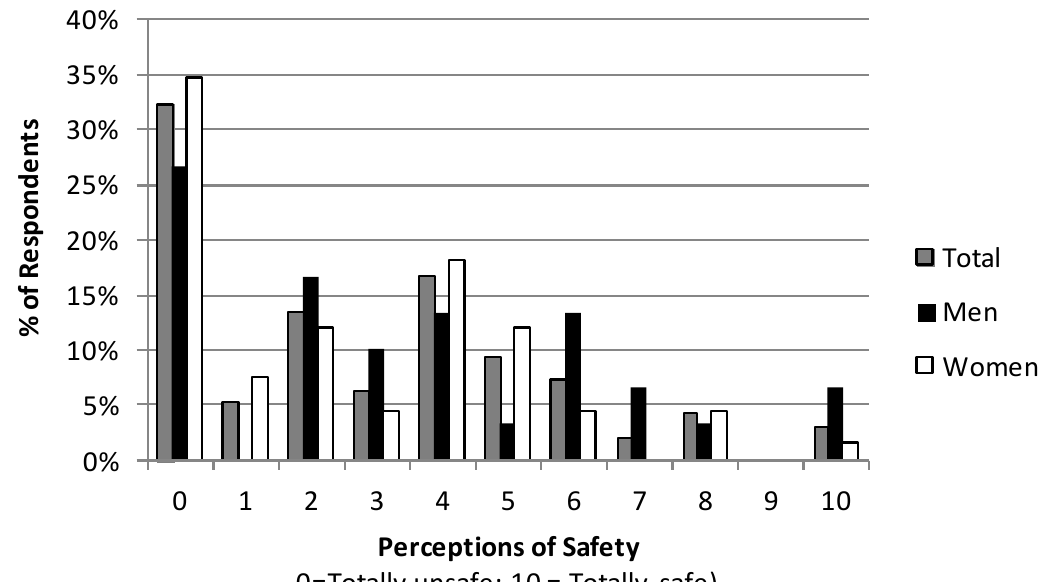
Figure 1. Respondents’ perceptions of health risks from smoke